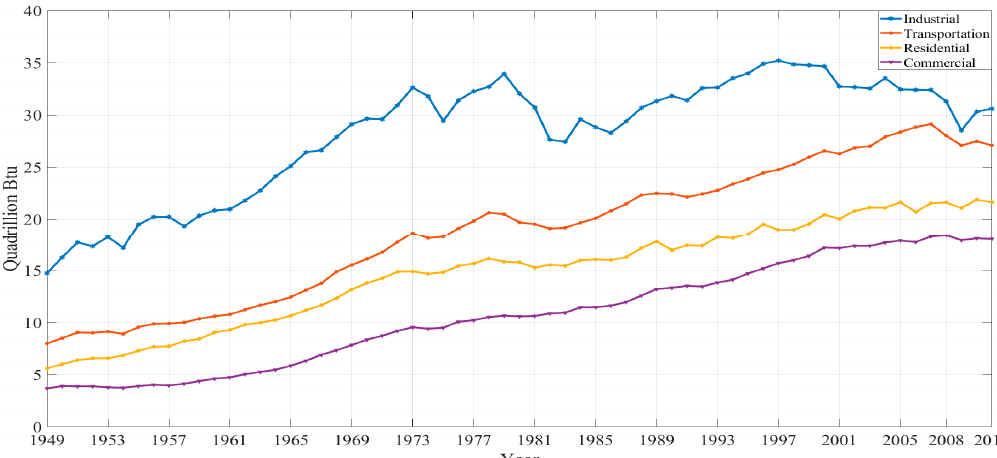
Figure 1. Energy consumption of industrial, transportation, residential and commercial sectors in the US since 1950 [2].